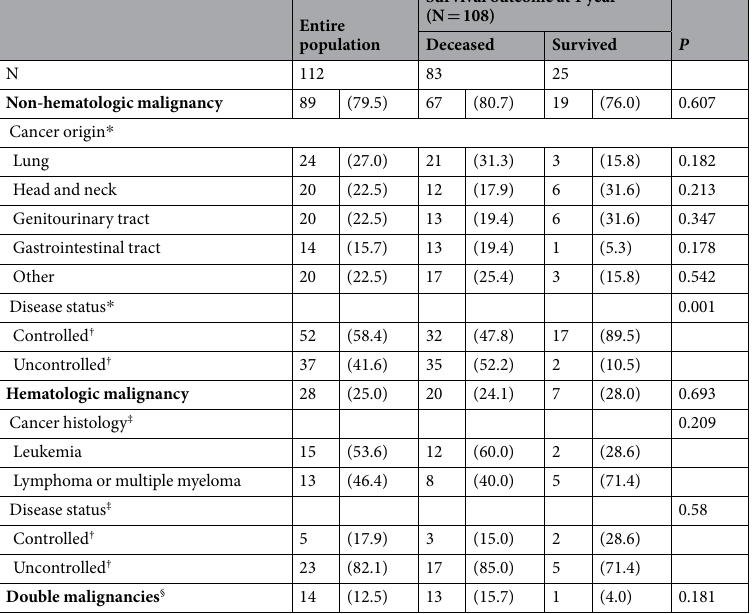
Table 1. Hemato-oncologic diagnoses of the study population. Data are presented as number (%). * Number (%) among patients with non-hematologic malignancy (n = 89). † Disease conditions classified as cure, complete remission, partial remission, or stable disease were considered controlled, while those classified as progressive or newly-diagnosed diseases were considered uncontrolled. In patients with non-hematologic malignancies from two different origins, the disease status was defined as uncontrolled if either one was uncontrolled. ‡ Number (%) among patients with hematologic malignancy (n = 28). § Nine patients with solid cancers from two different origins, 4 patients with both solid cancer and hematologic malignancy, and 1 patient with hematologic malignancy and solid cancers from two different origins (triple